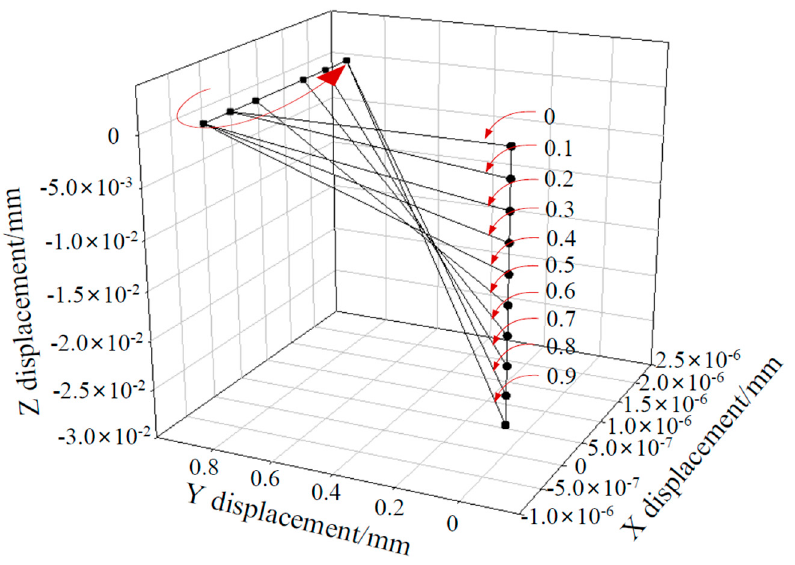
Figure 10. Spatial displacement of whiskers under drilling.